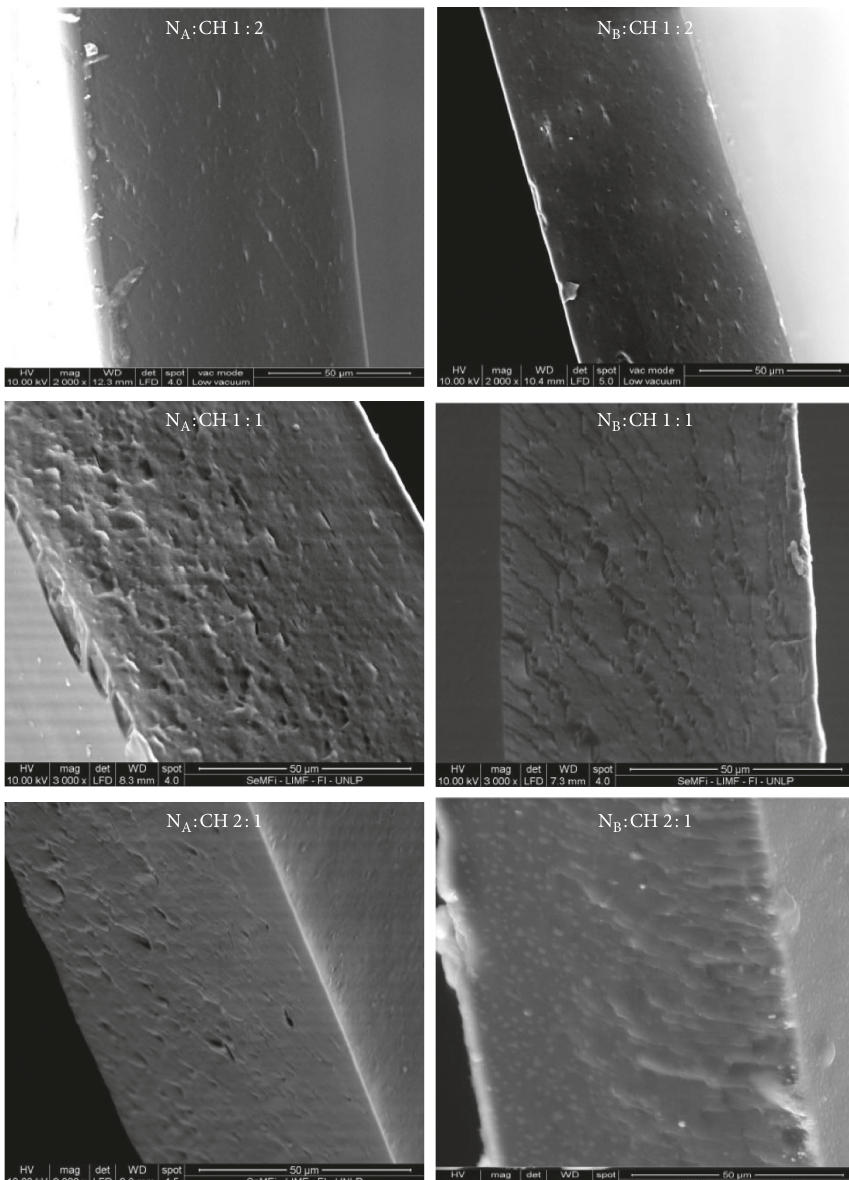
Figure 2: SEM cross-section micrographs of nanocomposite matrices with different N in